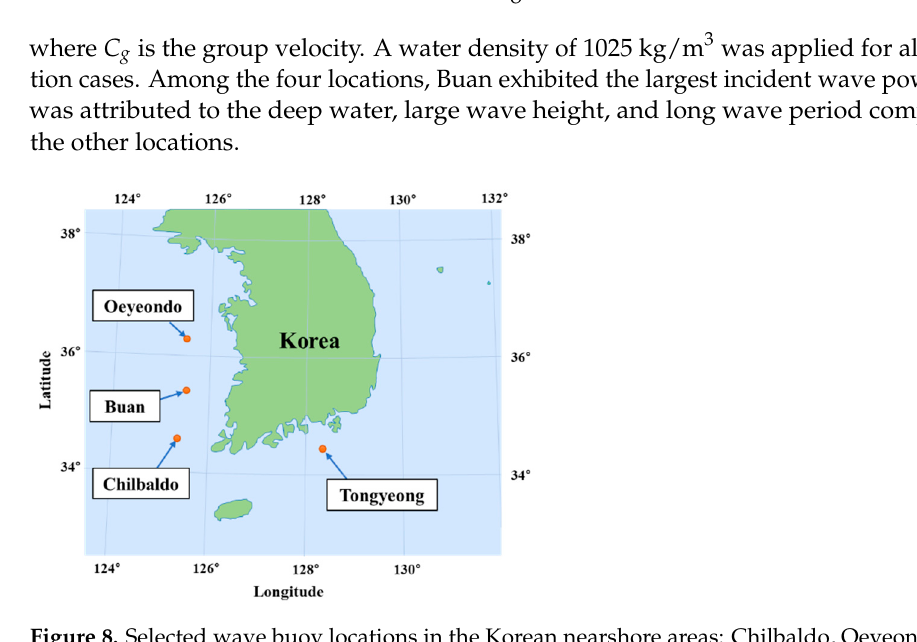
Figure 8. Selected wave buoy locations in the Korean nearshore areas: Chilbaldo, Oeyeondo, Buan, and Tongyeong. Table 2. Regular wave conditions calculated from buoy data in each selected area.